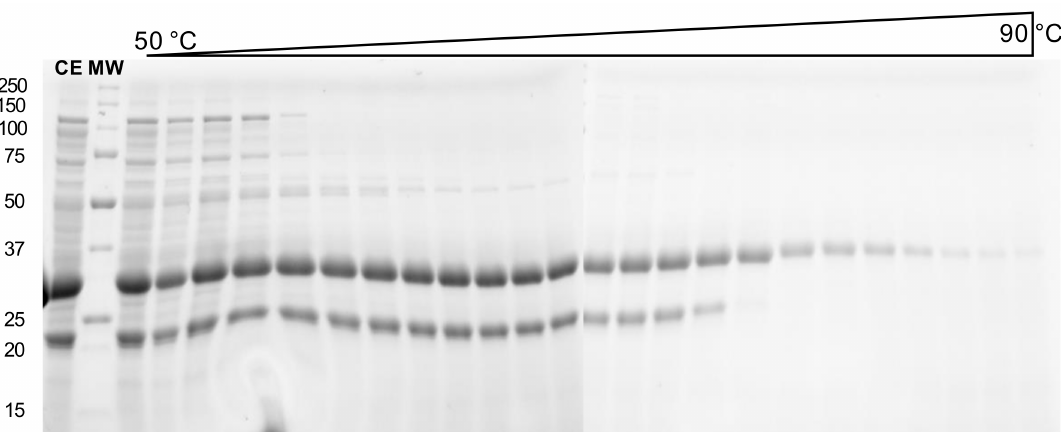
Figure 2. Denaturing condition gel electrophoresis analysis of TtEst2 purification through a heating protocol. CE: crude soluble extract; MW: molecular weight standards (reported in kDa on the left